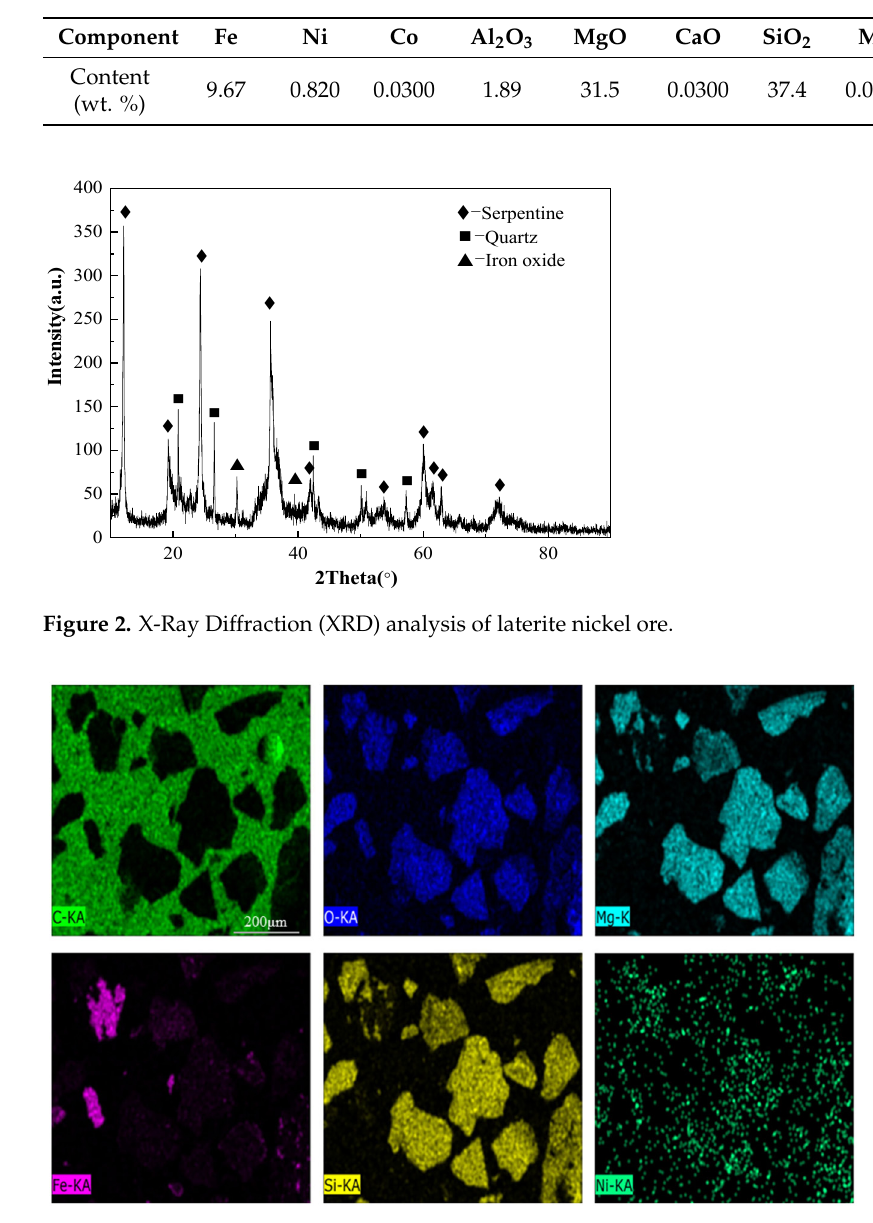
Figure 3. Scanning electron microscope of nickel laterite